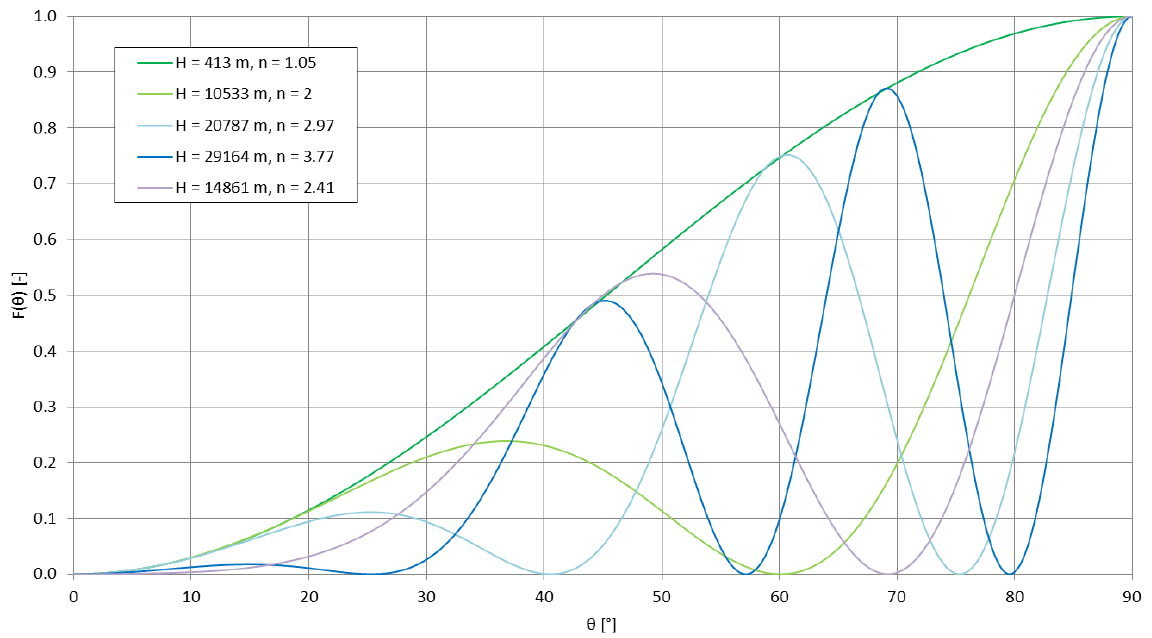
Figure 11. The antenna’s power pattern evolution with the changes of altitude and the respective numbers of lobes. As the pattern is axisymmetric, its cross-section between 0 and 90 degrees is shown. The n = 1.05 corresponds to the first altitude indication; for n = 2.97 the ground conductivity below the emitter changed from 0.004 to 0.008 S/m; for n = 3.77 the maximum altitude was reached; for n = 2.41, the ground conductivity below the emitter changed from 0.008 to 0.015 S/m.